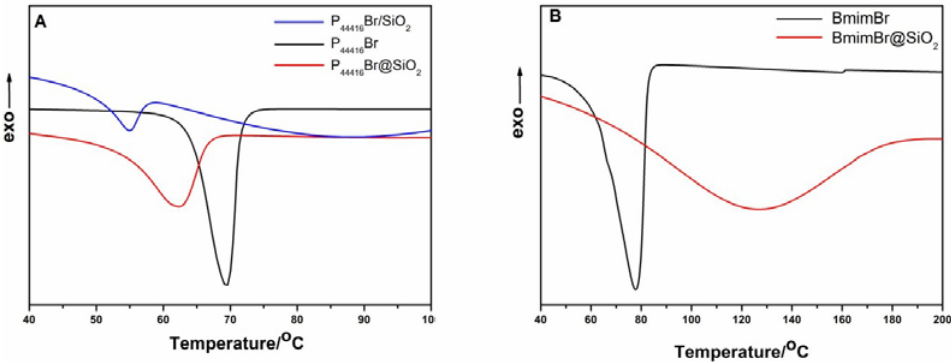
Figure 3. Differential scanning calorimetry (DSC) heating curves for ( A ) P P Br; P Br@SiO ; ( B ) BmimBr; BmimBr@SiO 44416 44416 2